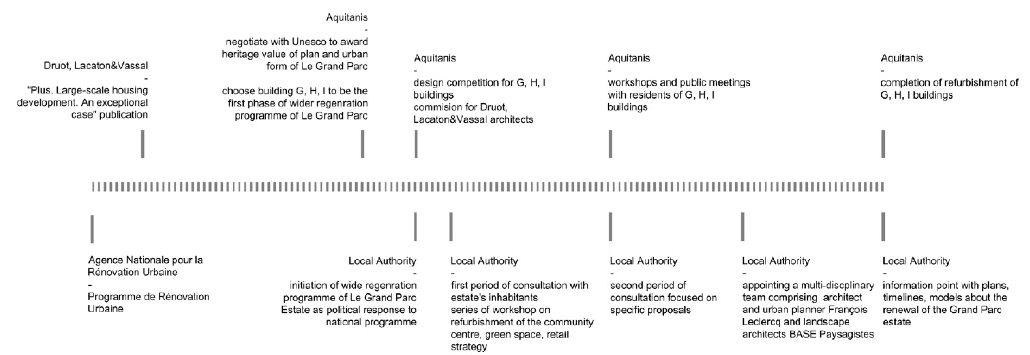
Figure 10. Timeline presenting actors and the process of modernization G, H, and I buildings in the Grand Parc Estate. Prepared by the author, based on [25].